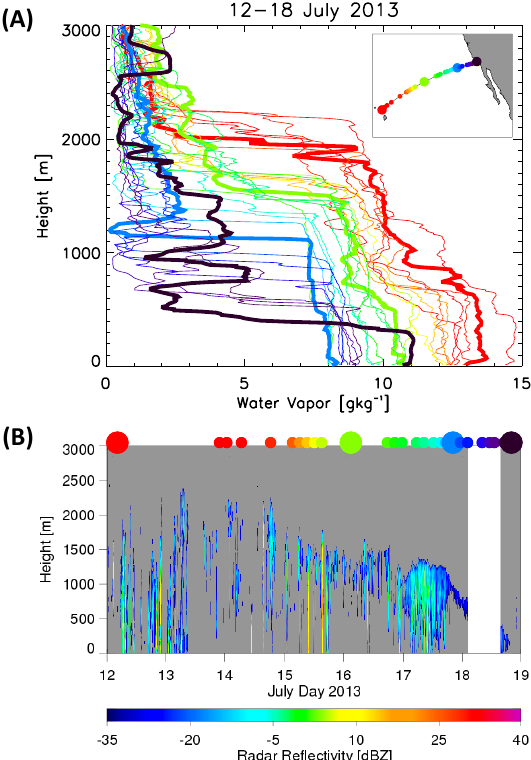
Figure 1. An example of water vapor profiles (a) and the associated cloudiness as shown by the radar reflectivity (b) from one leg of the MAGIC field deployment. MAGIC is the Marine ARM GPCI Investigation of Clouds, GPCI is the GEWEX Pacific Cross-section Intercomparison, and GEWEX is the Global Energy and Water Ex- changes. The leg took place between the 12 and 18 July 2013 start- ing in Hawaii and ending in Los Angeles. The vapor profiles are color coded according to location along the transect, which is shown in the inset map of panel (a) . The dots on top of panel (b) corre- spond to the location of each sounding in panel (a) . The white strip in panel (b) is a period where radar data are unavailable. The evolu- tion of the water vapor profile shows a clear transition from one that is well-mixed and shallow to one which grows deeper and more de- coupled with distance from the continent. Commensurate with this thermodynamic change is a reduction in cloud cover and an increase in the occurrence of